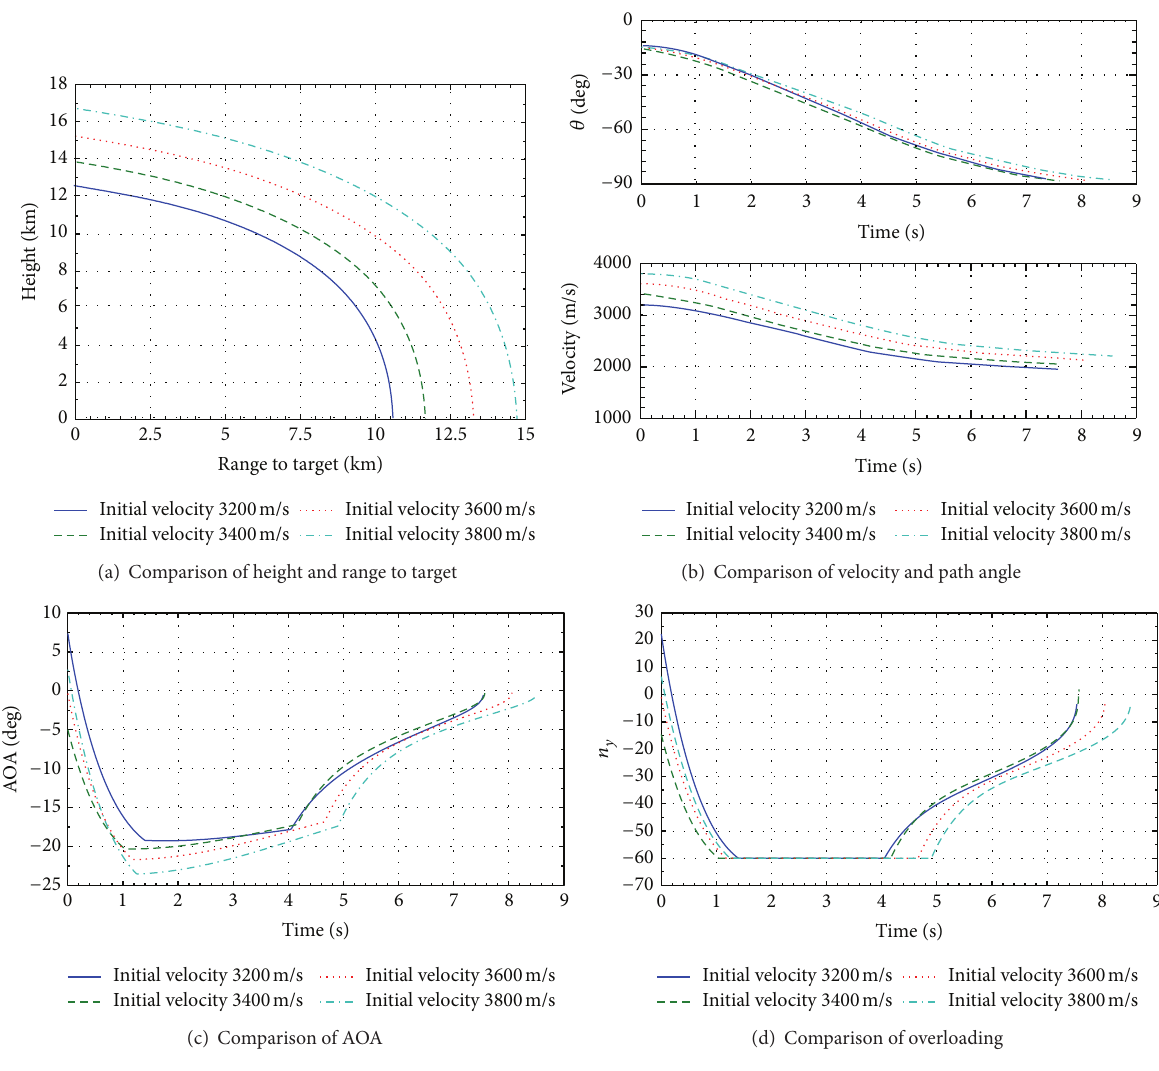
Figure 3: Comparison of flight characteristics of projectile in different initial condition.